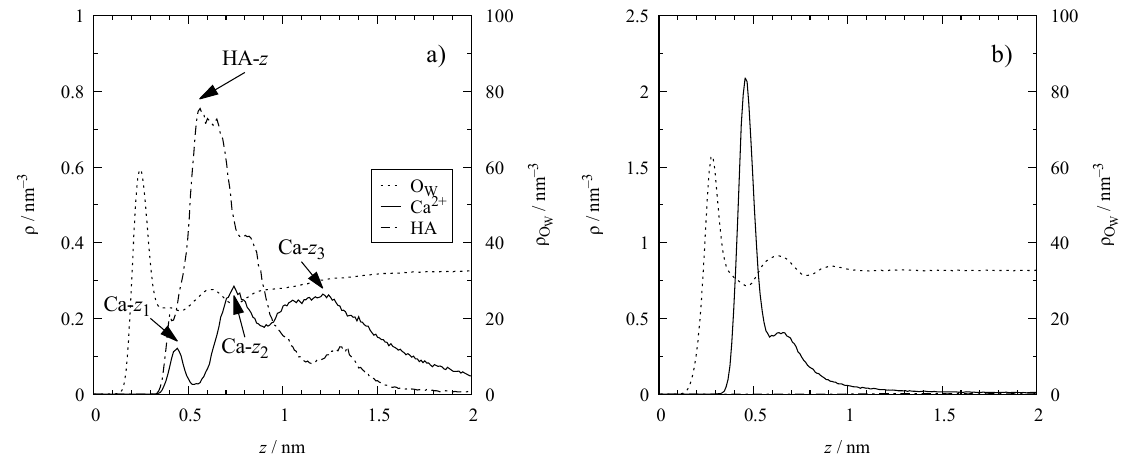
Figure 2. Probability distribution, ρ, of the oxygen atom of water (O W ), calcium cation (Ca 2+ ) and humic acid center of mass (HA) as a function of the distance, z , from the aluminol ( a ) and siloxane surfaces ( b ). Basal oxygen atoms of both surfaces are taken as a reference position ( z = 0). The maxima adsorption regions of Ca 2+ and HA on the aluminol side are located at z = 0.44 (Ca– z 1 ), z = 0.76 (Ca– z 2 ), z = 1.21 (Ca– z 3 ) and z = 0.56 nm (HA– z ).